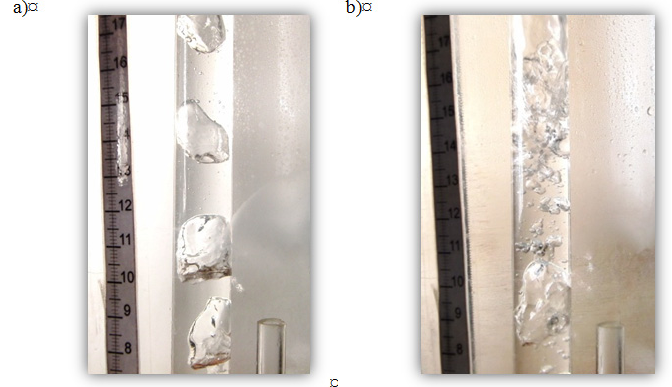
Figure 17. Structure of two-phase flow in a vapor lift pump: ( a ) slug flow at 600 W; ( b ) froth flow at 1200 W.